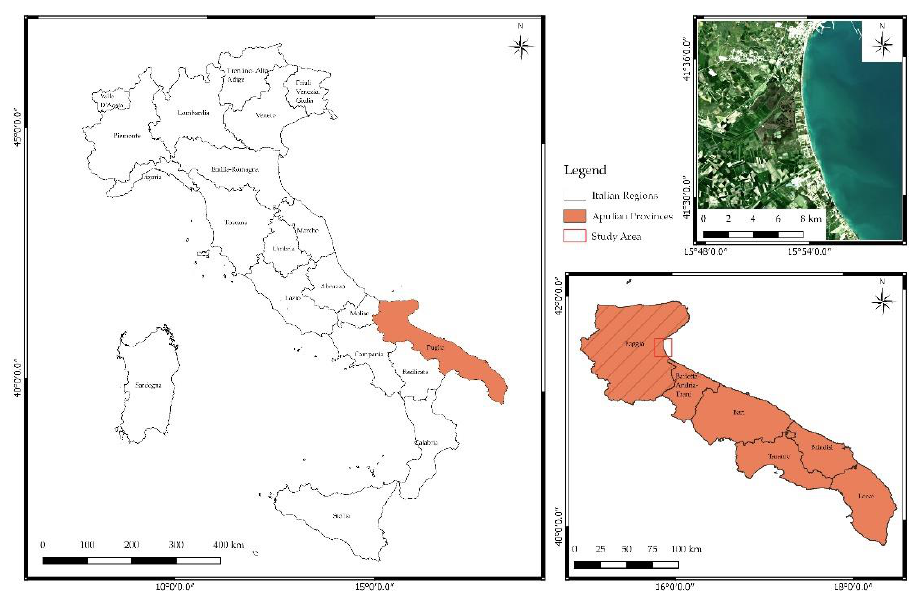
Figure 1. Study Figure 1. Study area.